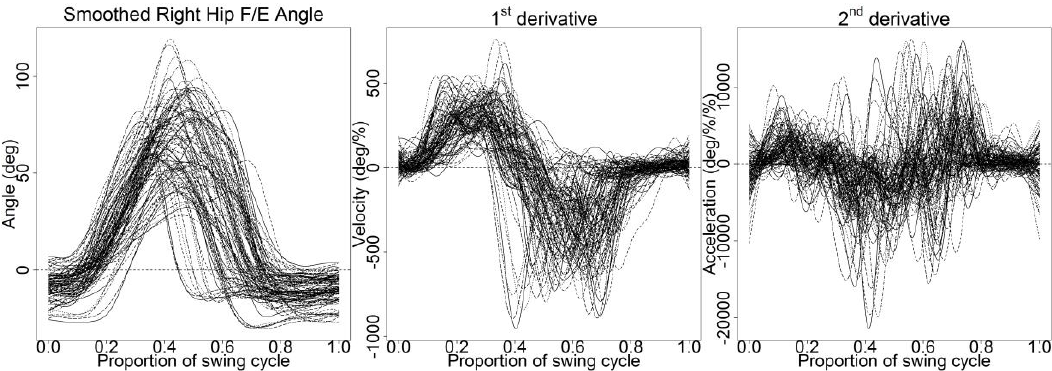
Figure 6. Smoothed right hip flexion/extension (F/E) angle of 100 trials from 20 subjects and their respective first and second-derivative curves during AKS.